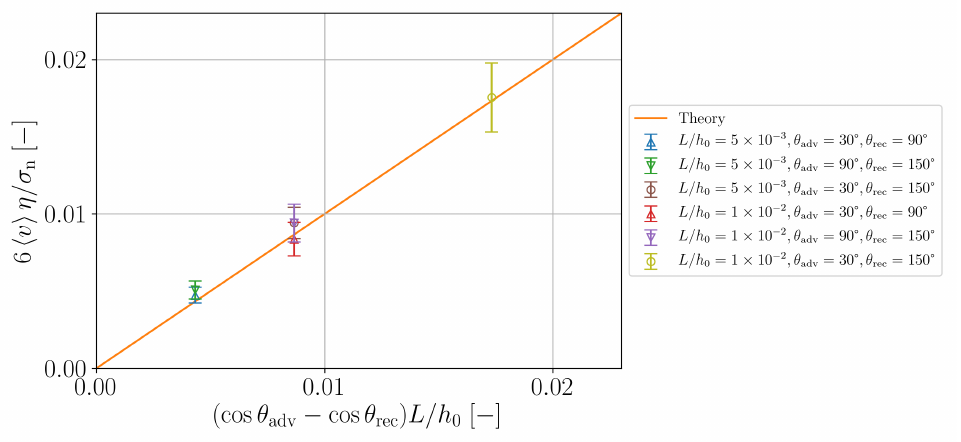
Figure 15. Normalized velocity as function of normalized pressure gradient in the simulations and according to theory (Equation